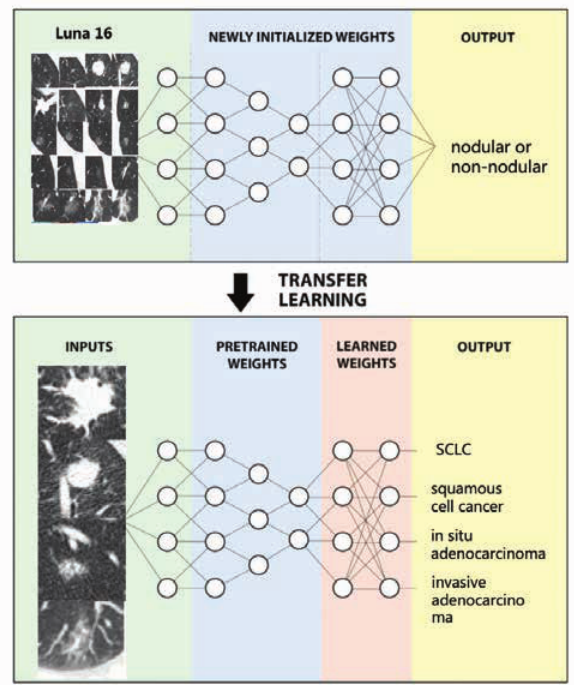
Figure 5: The general framework of the transfer learning strategy. The upper part is pre-training, and the lower part is fine-tuning. When we do fine-tune process, we update the weights of some layers.